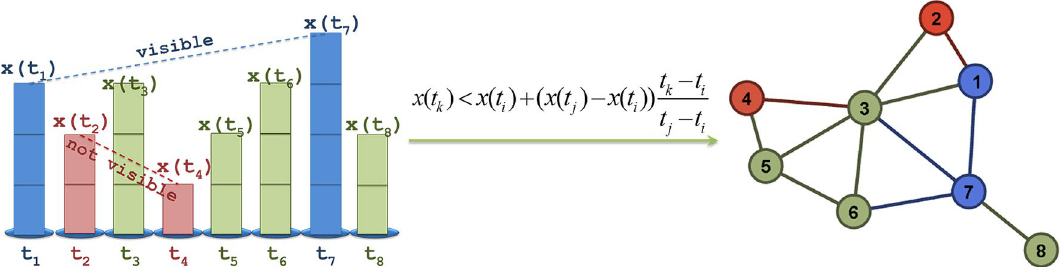
Figure 6. (left) Example a pair of visible (shown in blue colour) and another of not visible (shown in red colour) time-series nodes (generally shown in green colour) defined according to the natural visibility algorithm (NVG), (right) the visibility graph generated from the time-series shown at the left